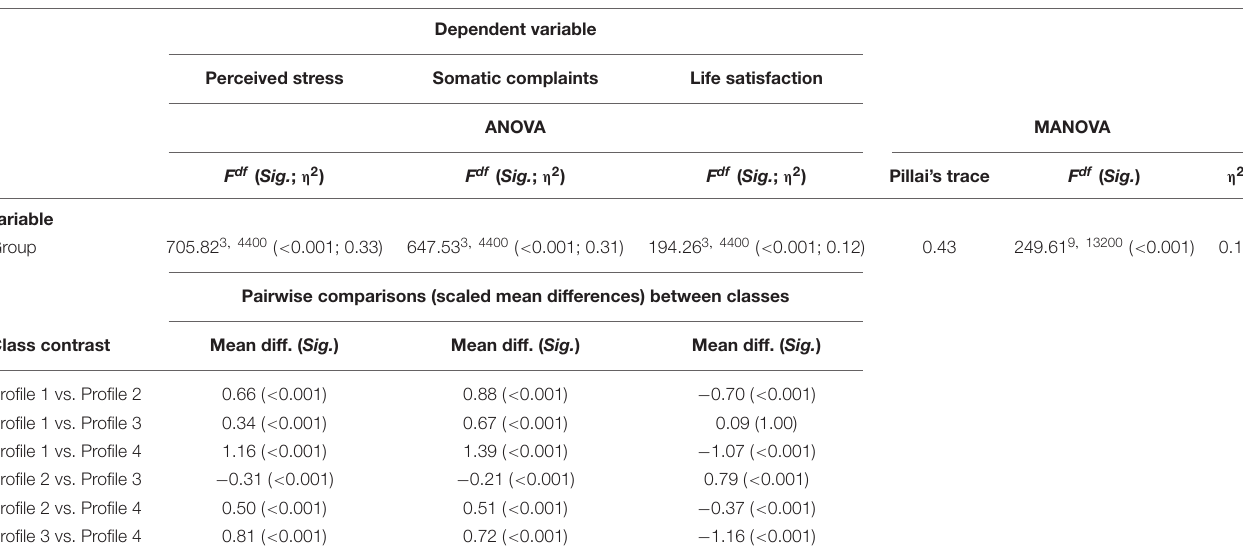
TABLE 3 | The effects of group (latent profile) in relation to perceived stress, somatic complaints, and life